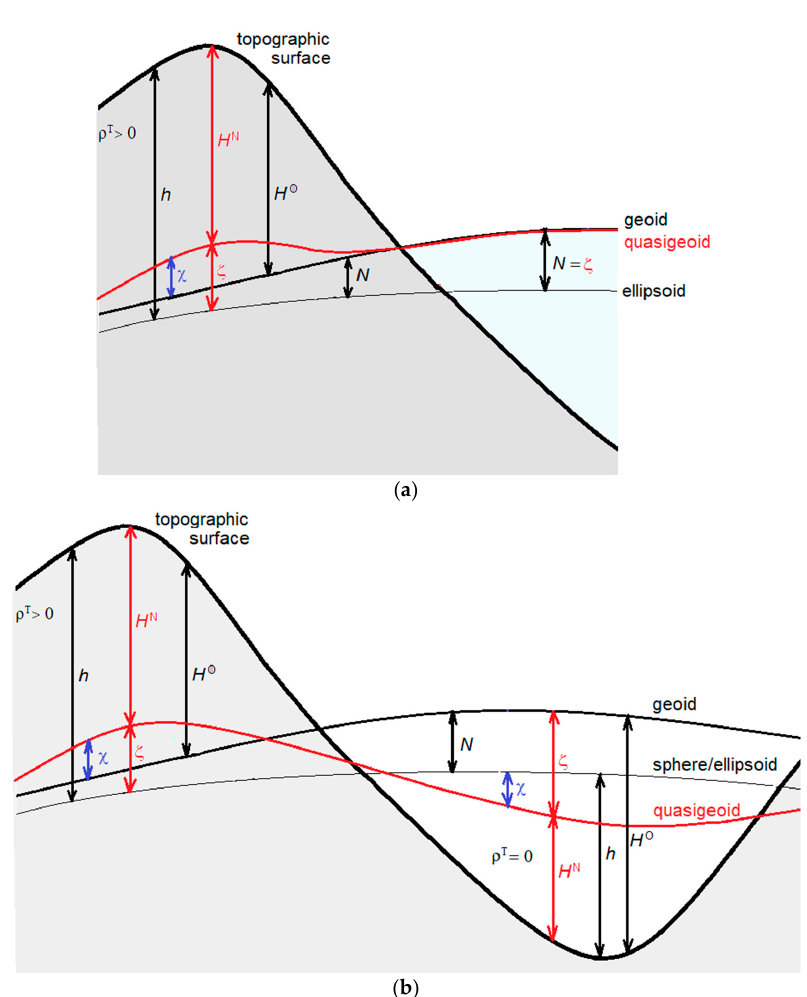
Figure 1. Definition of physical heights on ( a ) Earth and ( b ) planetary bodies. Notation: h the geometric height, H O the orthometric height, H N the normal height, N the geoid height, ς the quasigeoid height, and χ the geoid-to-quasigeoid